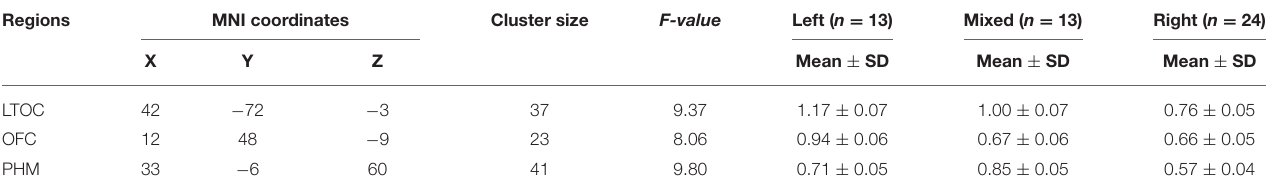
TABLE 2 | Voxel-mirrored homotopic connectivity (VHMC) statistics for the groups.